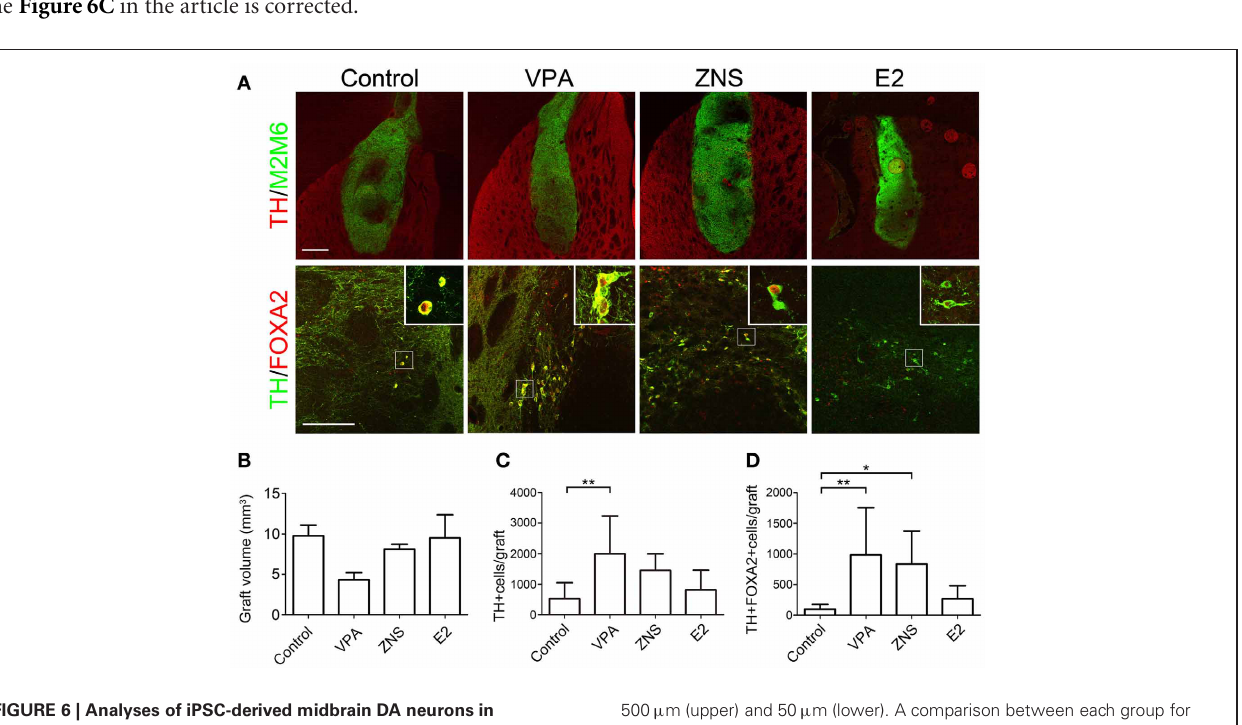
FIGURE 6 | Analyses of iPSC-derived midbrain DA neurons in animals treated withVPA, ZNS, or E2. (A) Representative immunohistologic images of grafts (M2M6; green) containing DA neurons (TH; red), FOXA2 (ventral-midbrain marker; red), and TH (DA neuron marker; green). The scale bar applies to all pictures and represents